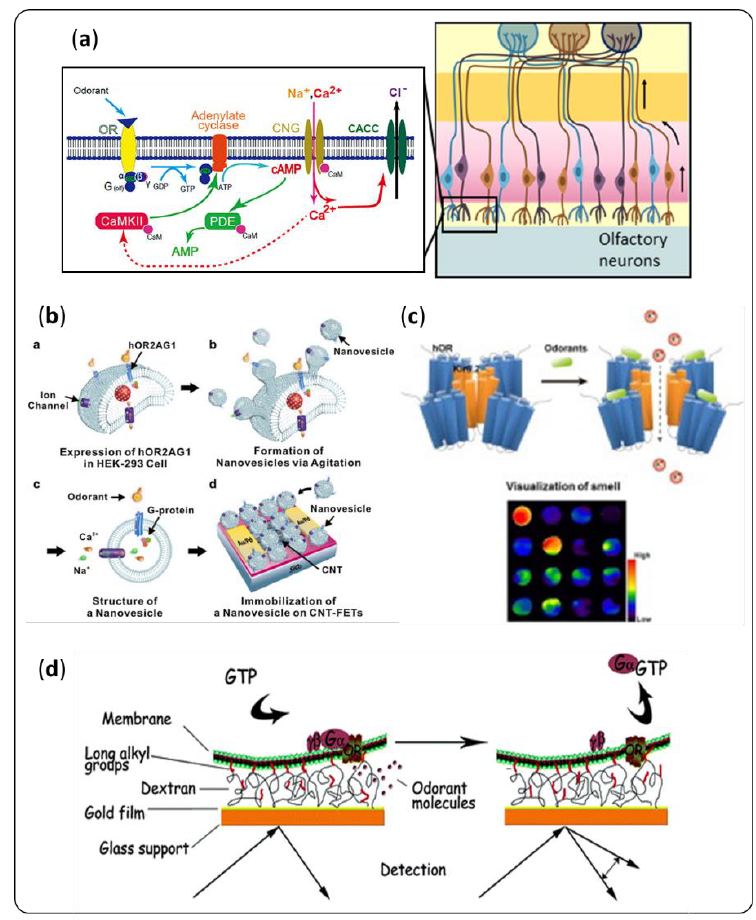
Figure 9. ( a ) The olfactory neurons are the biological transducers of the olfactory signal. On the left is a schematic representation of the 3, 5-cyclic monophosphate (cAMP) signaling pathway [148]. This process inspired different designs to achieve highly sensitive detection of VOCs. ( b ) Jin et al. [23] integrated nanovesicles containing ORs and ion channels on field–effect transistors to enhance the potential difference caused by VOC binding. ( c ) Oh et al. [149] designed ion channel-coupled ORs for fundamental research purpose that could be integrated in biosensors. ( d ) The design proposed by Vidic et al. [22] used the desorption of the G protein upon VOC binding to enhance an SPR signal.